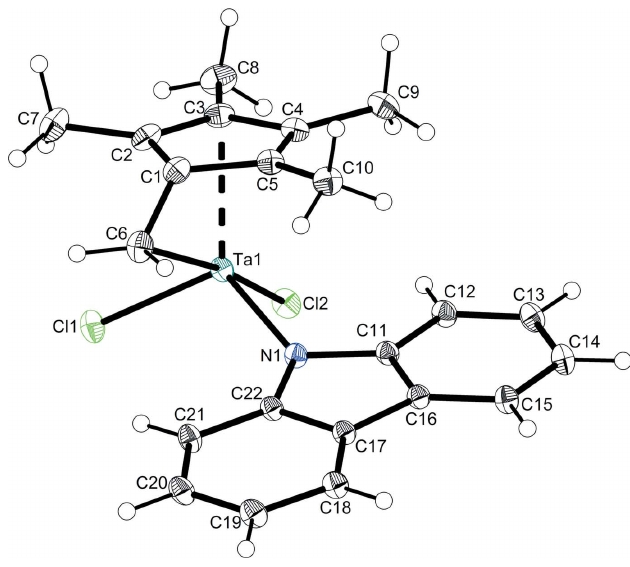
Figure 1 Molecular structure of 2. Displacement ellipsoids correspond to the 50% probability